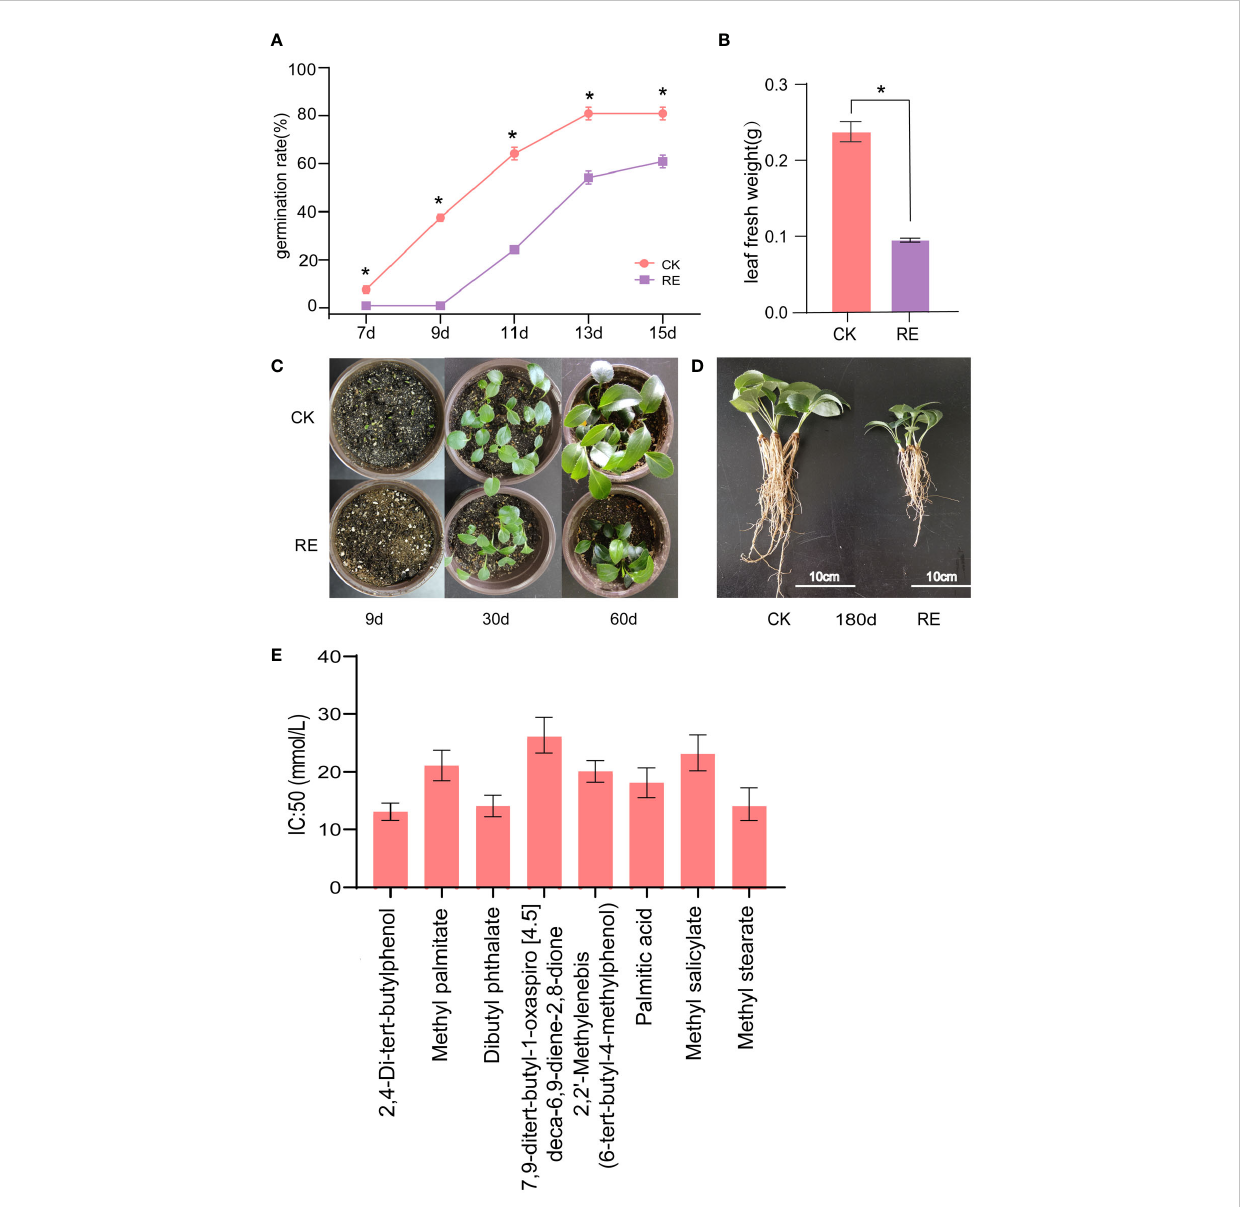
FIGURE 2 Autotoxic effects of the rhizosphere soil extracts of A lancea . (A) Seed germination rate. (B) Leaf fresh weight. (C) Growth morphology of A lancea at day 9, 30, and 60 after sowing. (D) A lancea seedling on day 180. Values represent means ± SD (n = 3 replicates with 30 plants). (E) The half- maximal inhibitory concentrations (IC 50 ) of the compounds. *, signi fi cant difference between the CK and RE (p < 0.05). CK, control; RE, rhizosphere soil